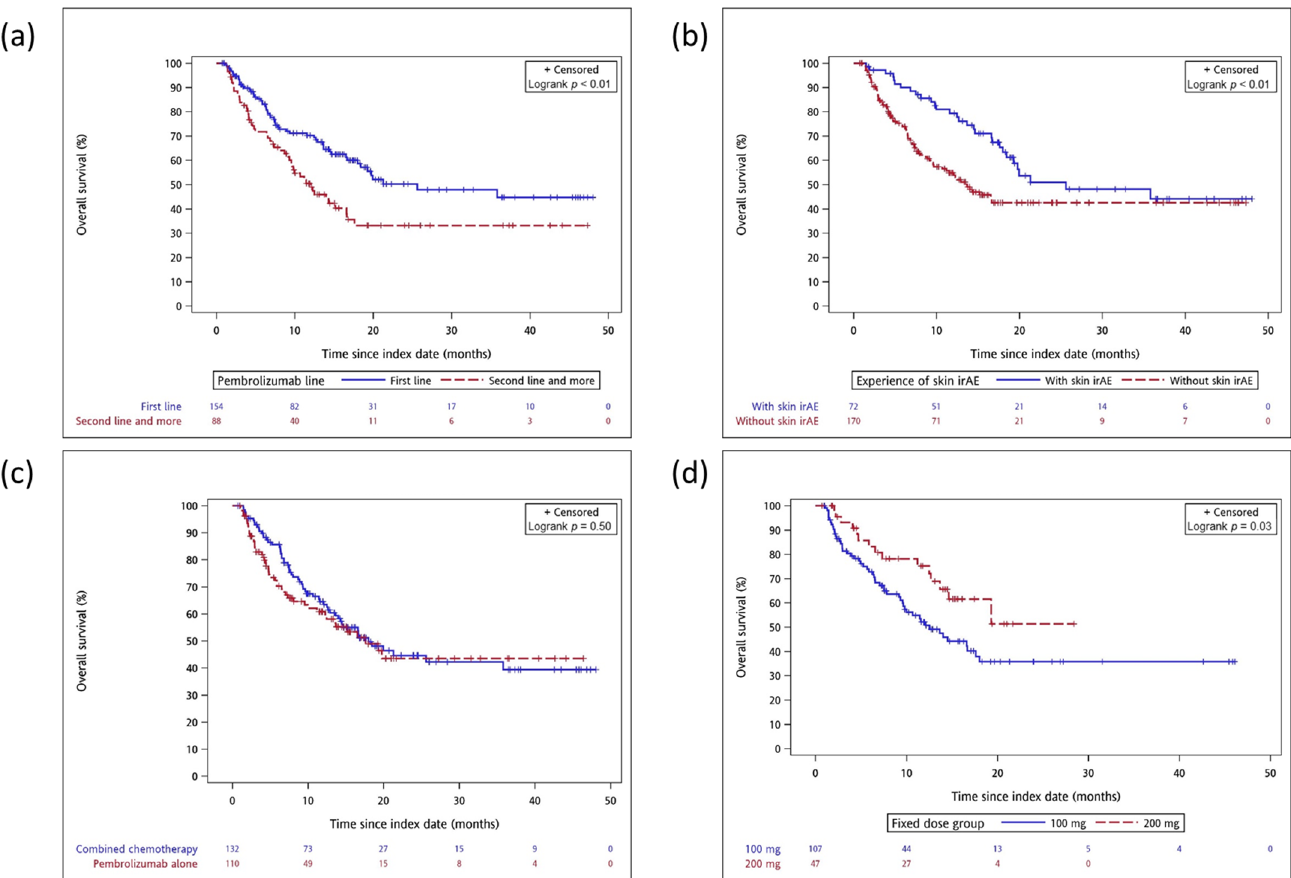
Figure 4. Post hoc subgroup analyses of weighted Kaplan–Meier survival curve by clinically specific group after IPTW adjustment. ( a ) Pembrolizumab first line vs. second line and more; ( b ) Skin irAEs vs. Non–skin irAEs; ( c ) Pembrolizumab alone vs. combined chemotherapy; ( d ) Pembrolizumab fixed dose 100 mg vs. 200 mg.